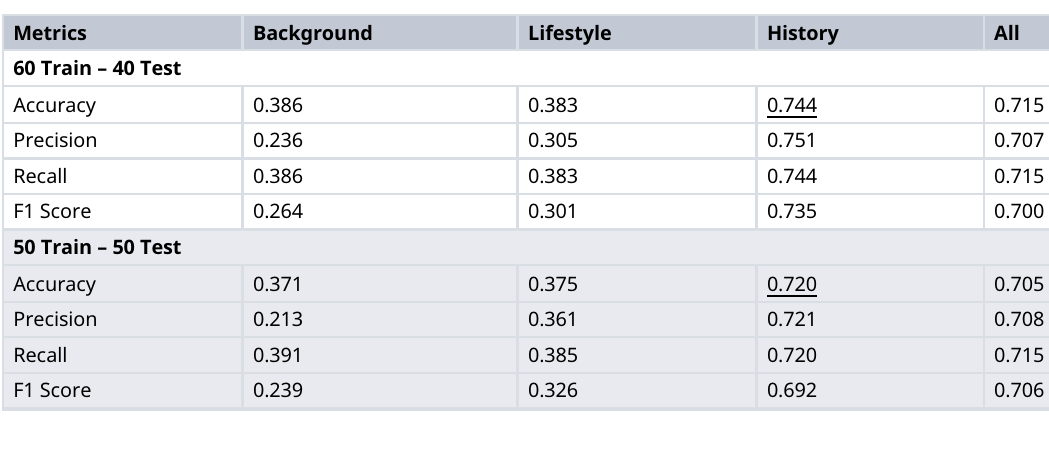
Table 12. Comparison of our models with others research work on two Portuguese secondary schools.